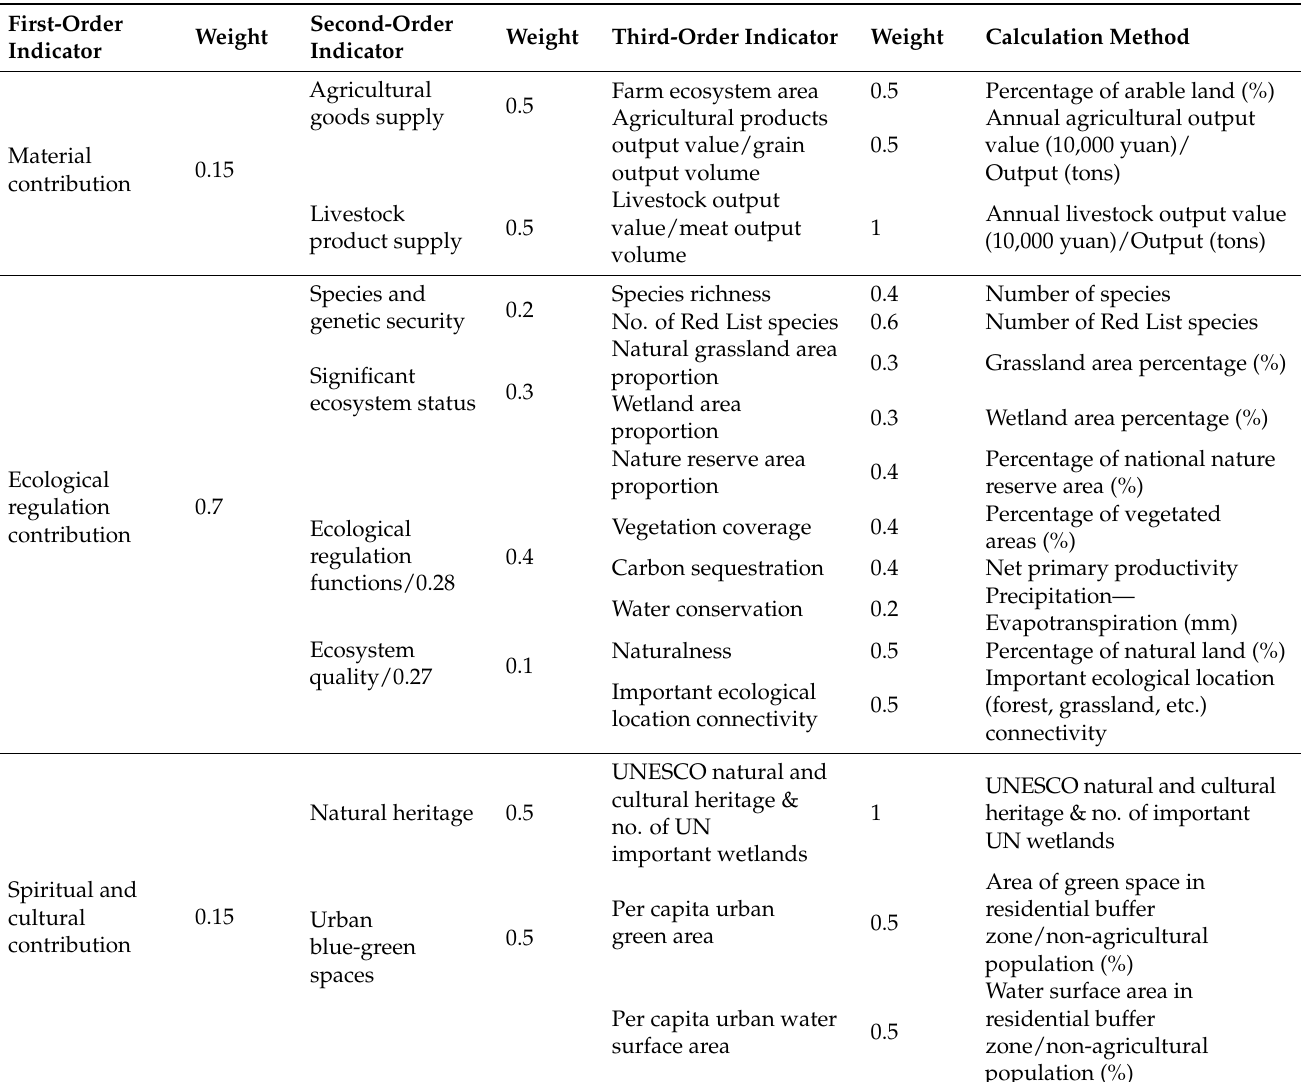
Table A2. Expert